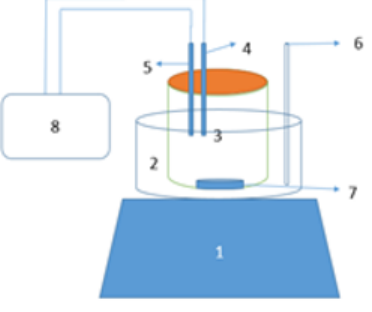
Figure 2. Schematic diagram of leaching set-up.